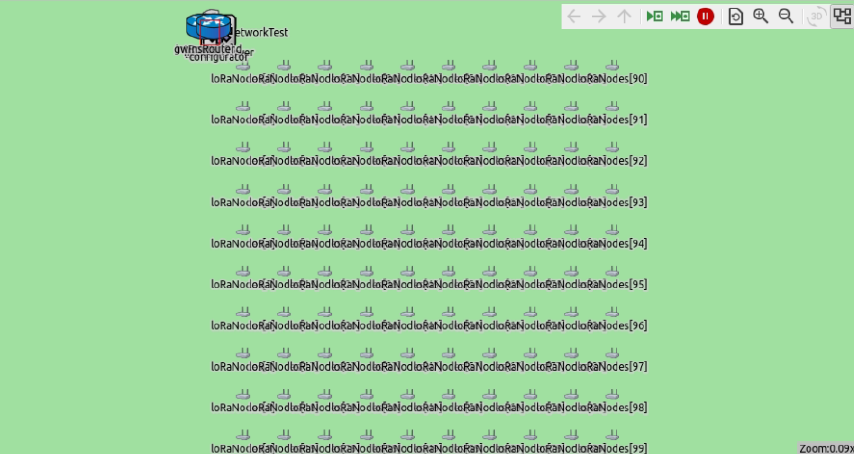
Figure 9. FLoRa simulation environment with 100 nodes placed in the simulation